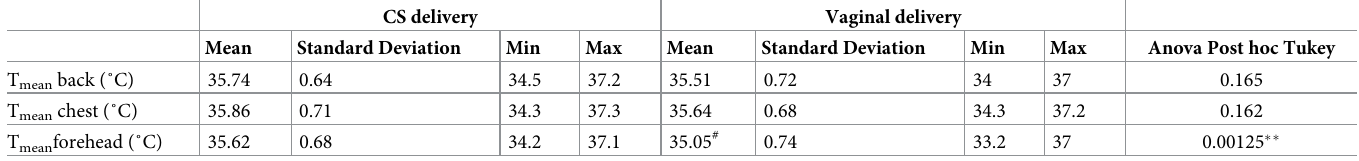
Table 2. Descriptive statistics of the temperature values of selected body surface areas in newborns born by CS and